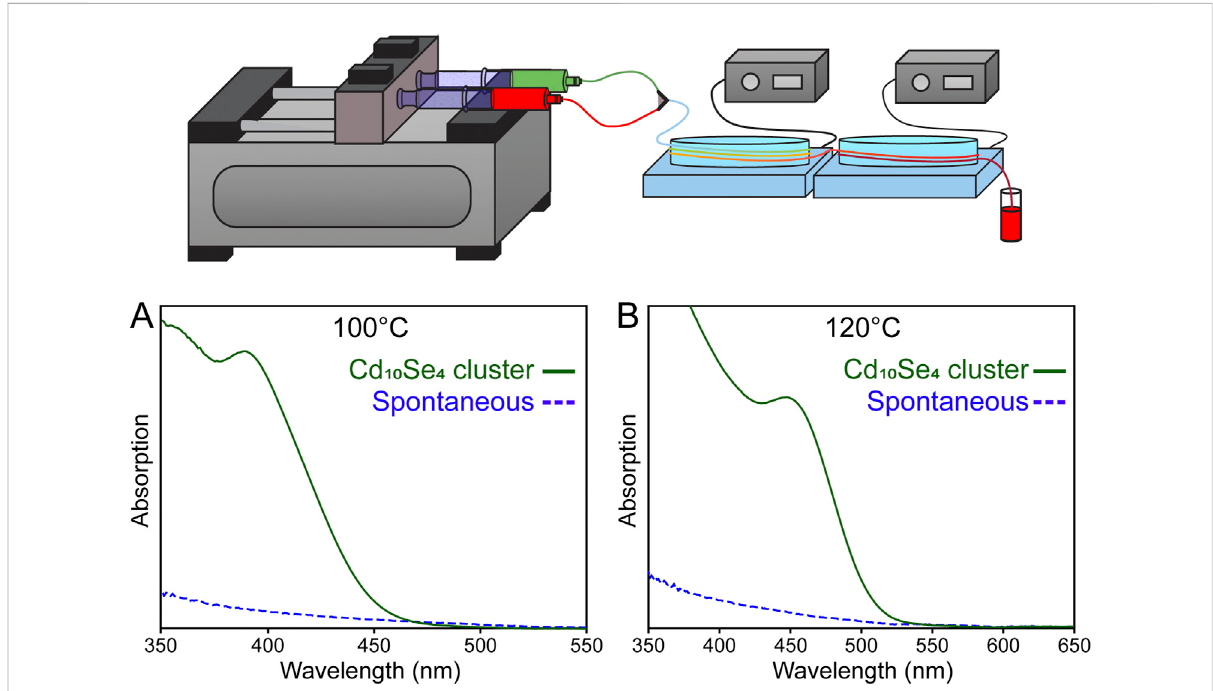
FIGURE 1 A scheme of a micro fl uidic reactor and CdSe QD absorption spectra with and without (NMe 4 ) 4 [Cd 10 Se 4 (SPh) 16 ] cluster seeds. Single-stage temperatures were (A) 100 ° C and (B) 120 ° C.